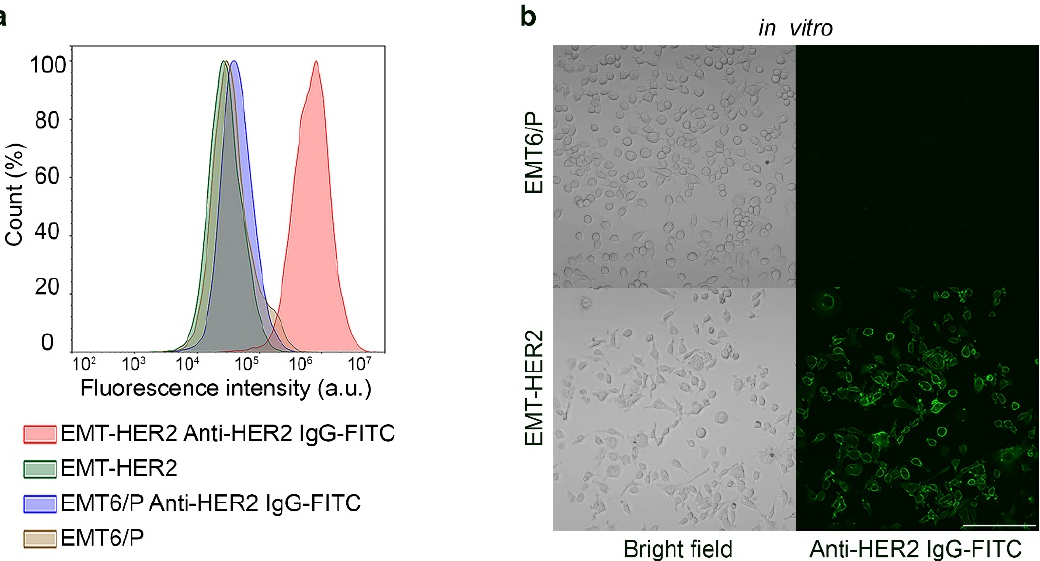
Figure 3. In vitro cell analysis of EMT-HER2 cells. ( a ) Flow cytometry analysis on cell labeling with anti-HER2 IgG-FITC. Initial EMT6/P and cells with HER2 (EMT-HER2) were labeled with anti- HER2 IgG-FITC and analyzed in the fluorescence channel corresponding to FITC fluorescence. ( b ) Confocal laser scanning microscopy of EMT6/P and EMT-HER2 cells labeled with Trastuzumab- FITC. Left panels—bright-field images; right panels—confocal images of the cells. Scale bar, 250 μ m. Next, these EMT-HER2 cells were s.c. injected into the right flank of BALB/c mice in